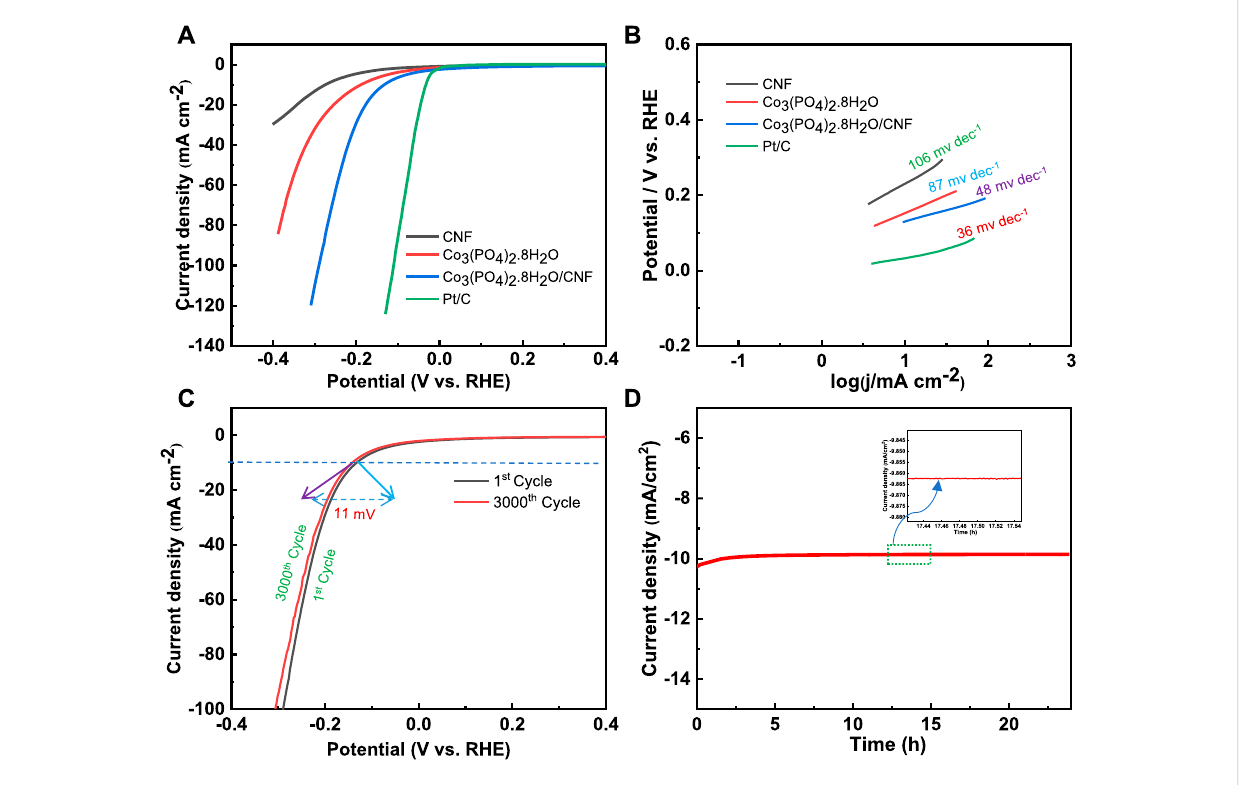
FIGURE 7 (A) Polarization curve (LSV) plot and (B) corresponding Tafel plot of Co 3 (PO 4 ) 2 .8H 2 O/CNF, Co 3 (PO 4 ) 2 .8H 2 O, and CNF, and Pt/C. (C) Chronoamperometry method ofCo